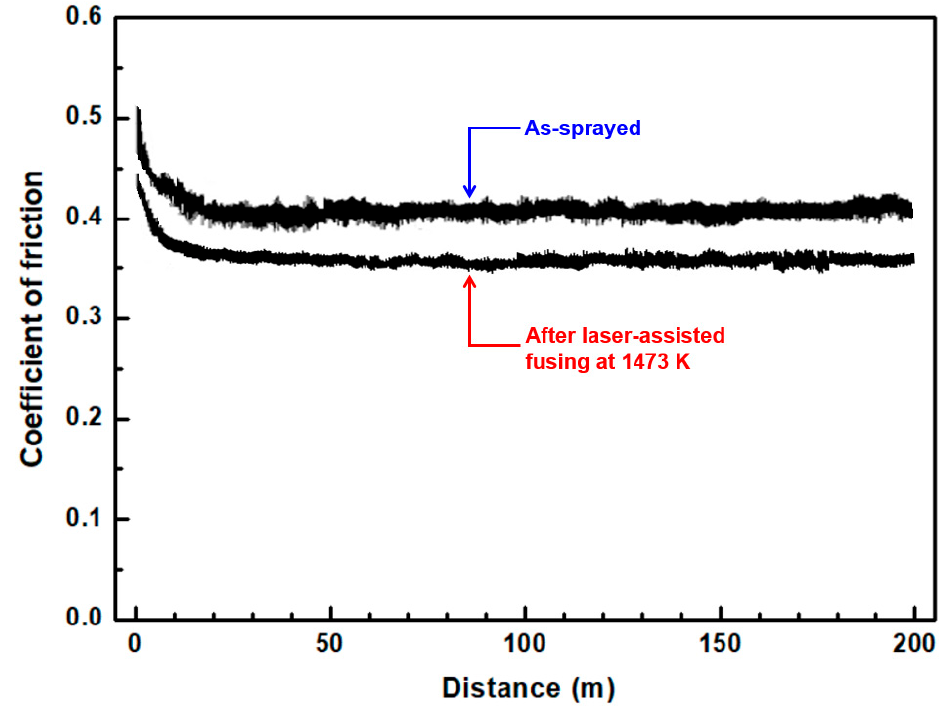
Figure 10. Comparison of coefficient of friction of thermal-sprayed 1276F coating and that after laser-assisted fusing at 1473 K.